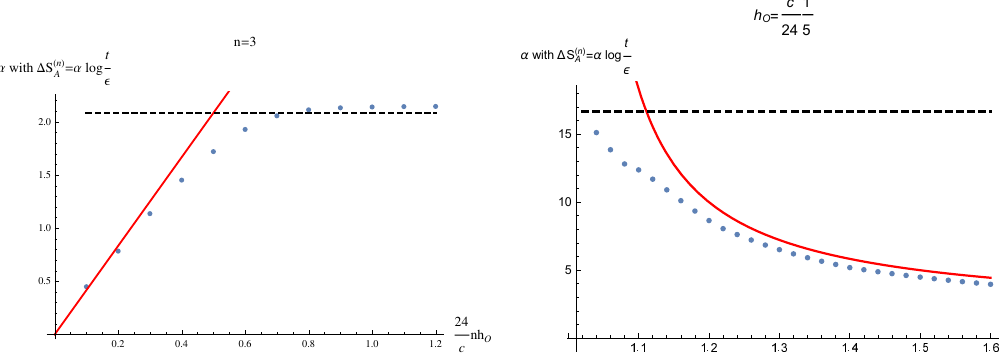
Figure 8 . The plots of the coefficient B ( n, h O ) of the logarithmic growth of entanglement entropy. The left is the case of the third Renyi entropy n = 3 for various values of h O (the vertical dotted line (A) in figure 1). The red line describes the formula (1.4) and the dotted horizontal line corresponds to the formula (4.6). The right is the case of h O = for various values of n (the horizontal dotted line (B) in figure 1). The dotted horizontal line and red curve correspond to the formula (1.3) and (1.4),